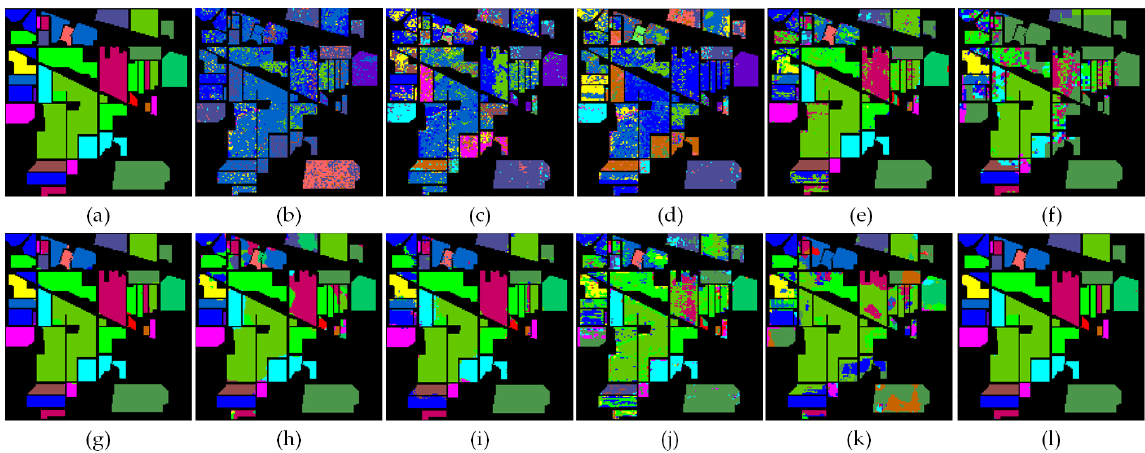
Figure 13. Classification results of the models in comparison with the IN dataset. ( a ) Ground-truth labels, ( b – l ) classification results of SVM, MLR, RF, 1D-CNN, 2D-CNN, 3D-CNN, Hybrid, JSSAN, RSSAN, TSCNN and SSMFF,